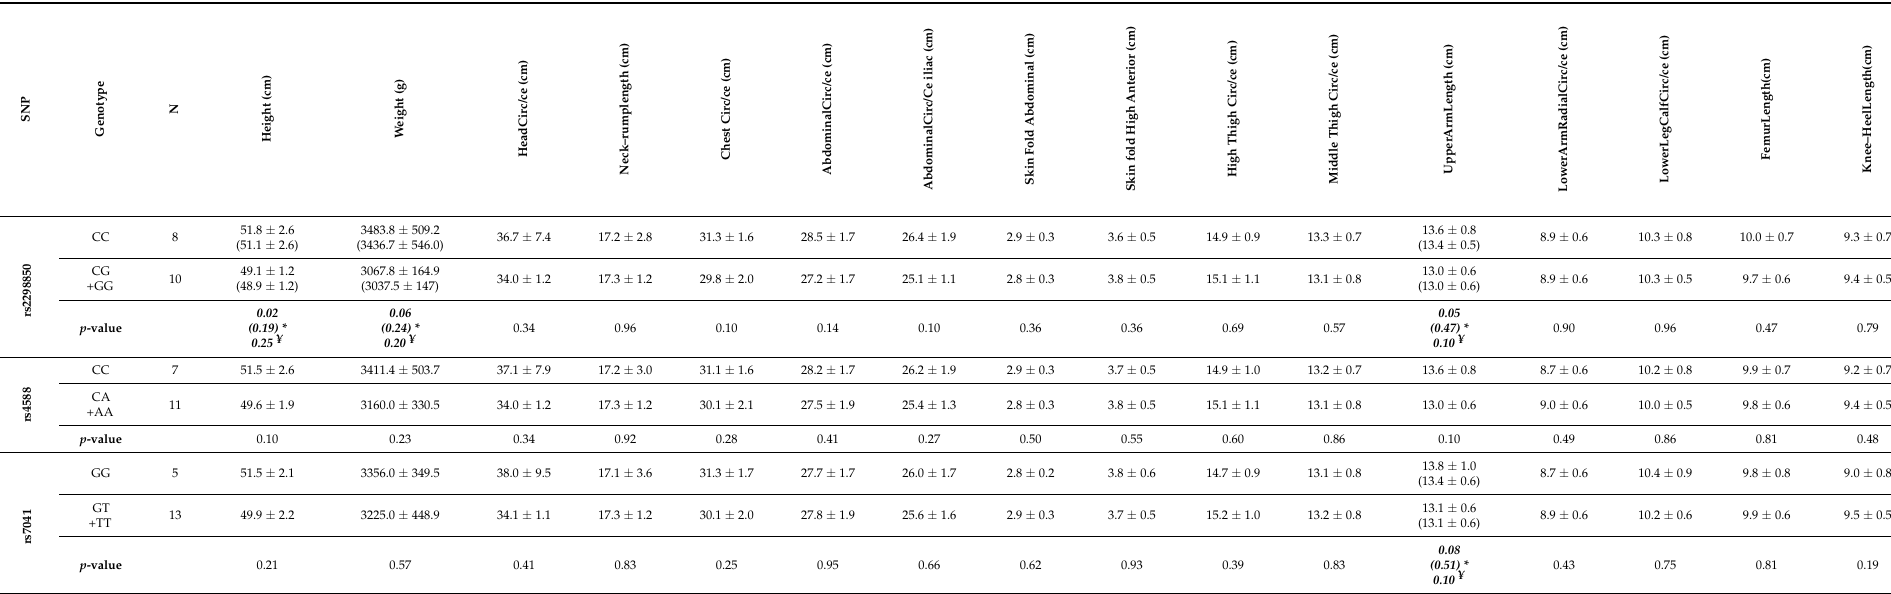
Table 2. Birth neonatal anthropometry (maternal 25(OH)D ≤ 25 nmol/L) according to maternal VDBP polymorphisms . If Levene’s Test for Equality of Variances p > 0.05 then Equal variances assumed Sig (2-tailed) p -values of T-Tests were given. If Levene’s Test for Equality of Variances p < 0.05 then Equal variances not assumed Sig (2-tailed) p -values of T-Tests were given. * The data and p -values adjusted for maternal height (cm), BMI pre-pregnancy (kg/m 2 ), BMI terminal (kg/m 2 ), UVB exposure, and weeks of gestation by One-way analysis of covariance (ANCOVA). Numbers in italics are after adjustments. ¥ Observed power